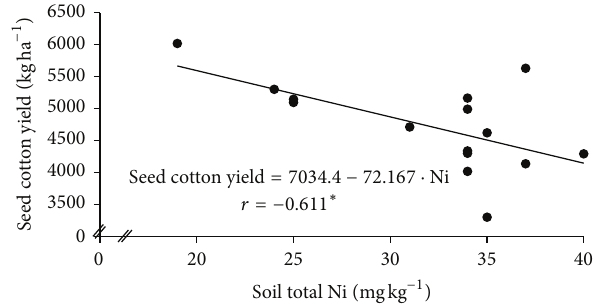
Figure 4: Relationship between Ni content of soil and seed cotton yield in the 2003 experiment ( ∗ 𝑝 < 0.05 ).